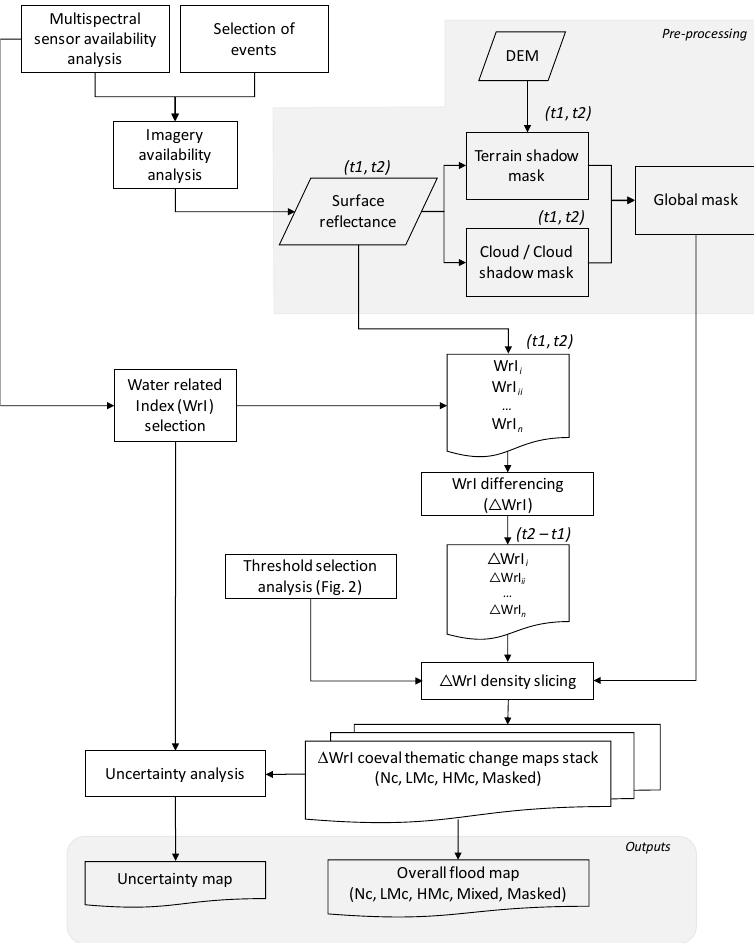
Figure 1. The Multi-INDEx Differencing (MINDED) method workflow.